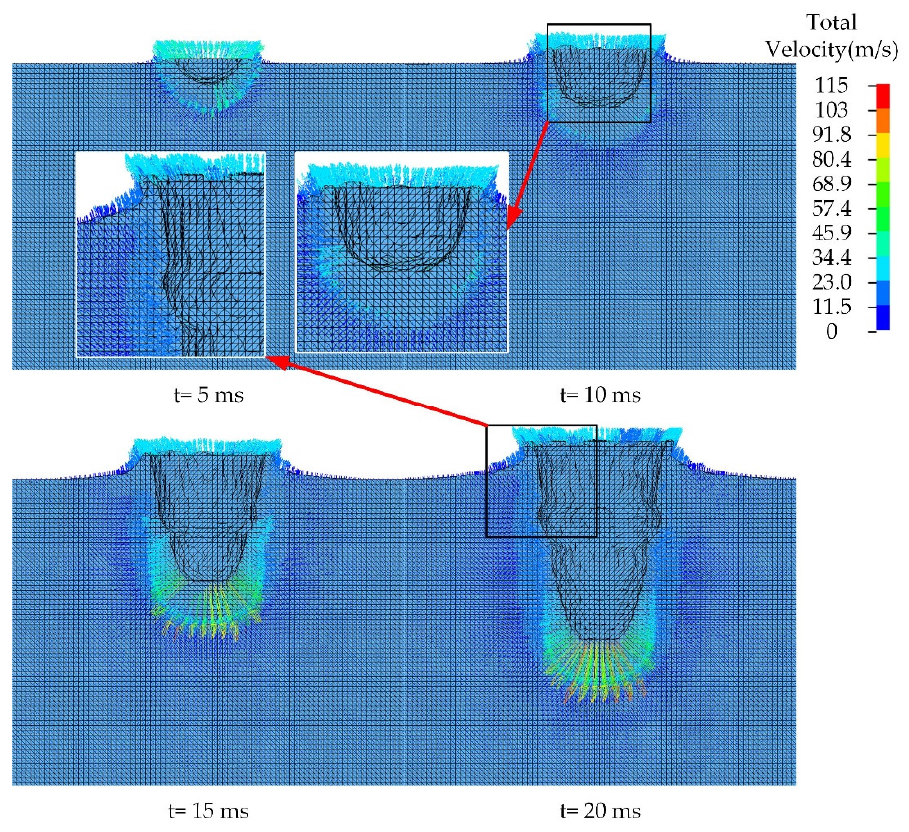
Figure 16. Schematic diagram of velocity of flow field.